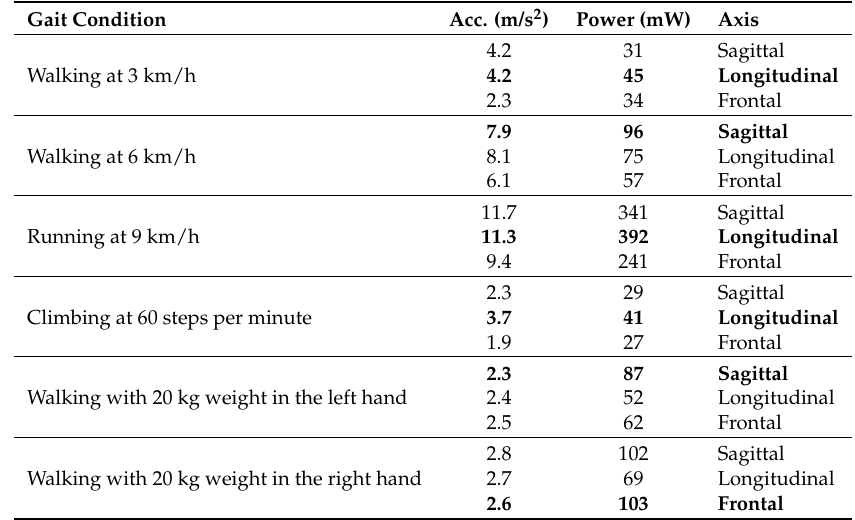
Figure 8. Simulated recoverable power from the prosthetics leg for selected gait conditions and axes. Table 1. Numerically predicted mean electrical power levels that can be generated from various gait conditions and axes from the regenerative prosthetics (one